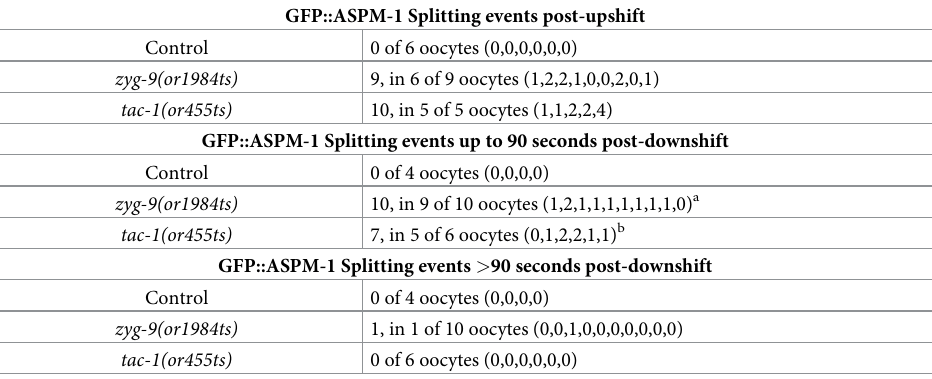
Table 2. ZYG-9 and TAC-1 Prevent the Splitting of Early Pole